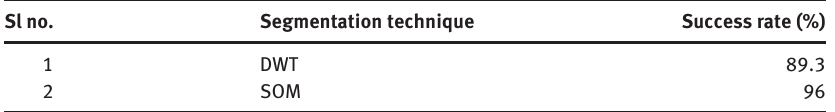
Table 6. DWT vs. SOM Segmentation Success Rate. Sl